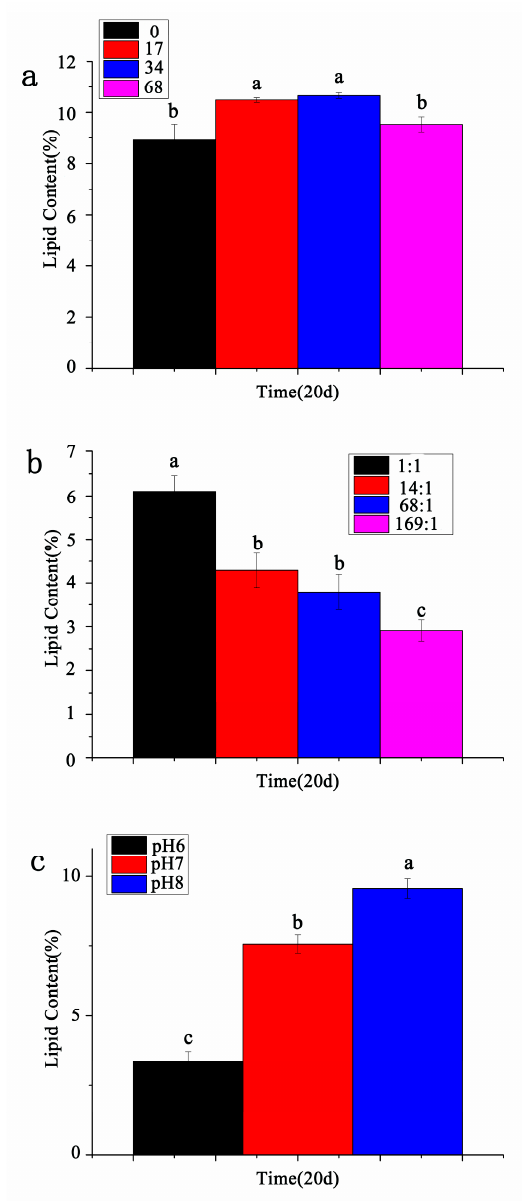
Figure 6. The content of total lipids of P. purpureum under di ff erent environmental factors. Data were expressed as mean ± standard error. ( a ). P. purpureum total lipid content under di ff erent salinity; ( b ). P. purpureum total lipid content under di ff erent N:P ratios; ( c ). P. purpureum total lipid content under di ff erent pH conditions.